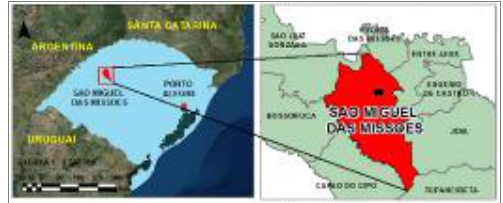
Figure 1 – Study Area: city of São Miguel das Missões.